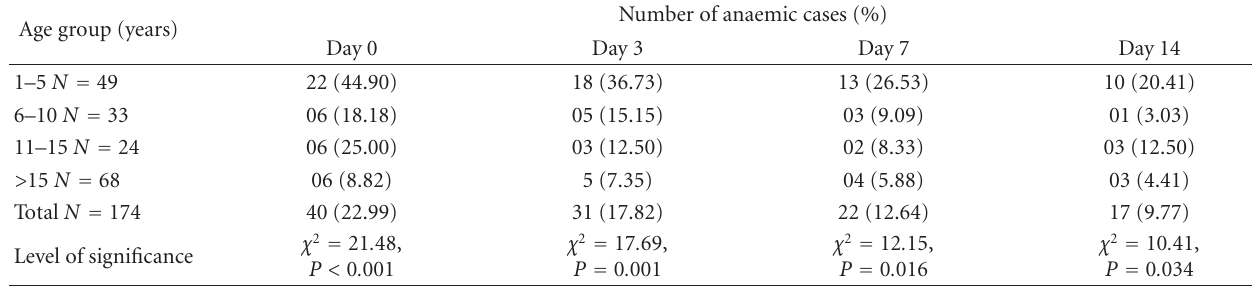
Table 5: Prevalence of anaemia in di ff erent age groups of patients attending CAMEF during the in vivo study, 2007-2008, during followup after treatment with Malartin and